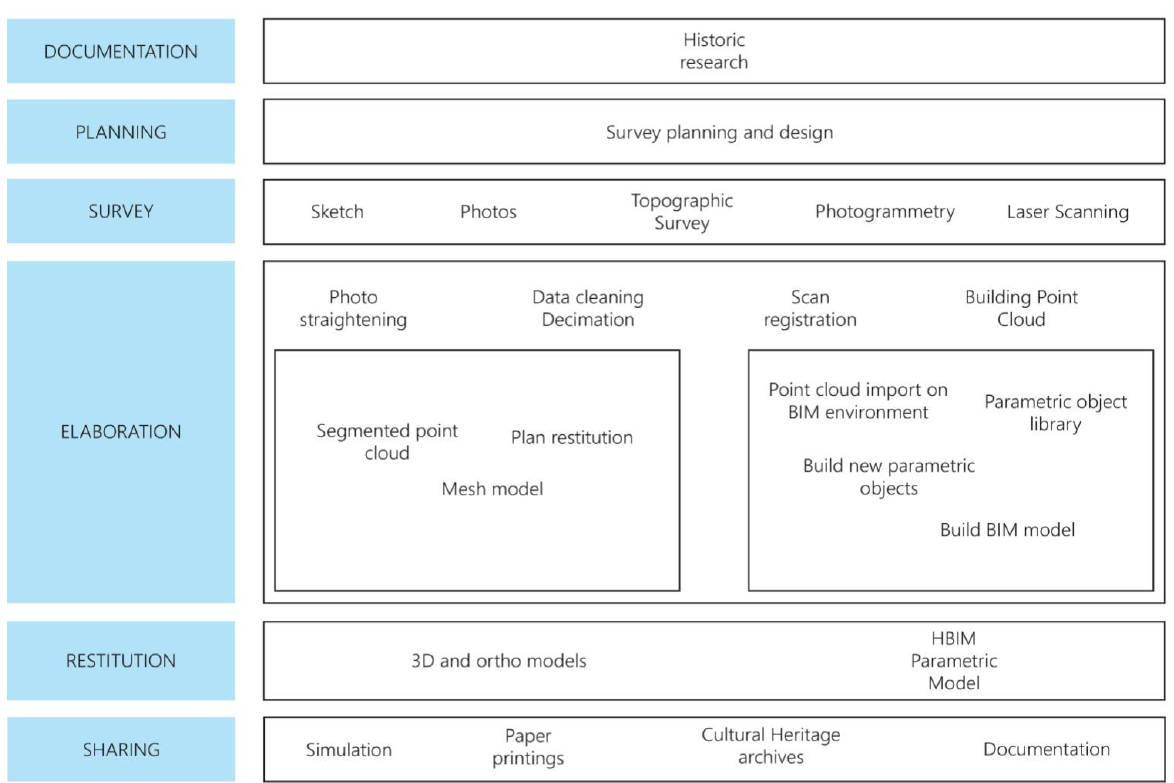
Figure 8. Graphic representation of the